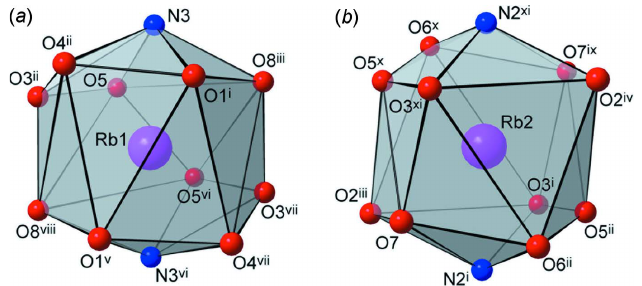
Figure 2 Twelvefold coordination environments adopted by the Rb1 and Rb2 ions in ( 1 ), in the form of distorted icosahedra. The coordination of the two Cs ions in ( 2 ) is almost identical. [Symmetry codes: (i) x , y + 1, z ; (ii) (cid:3) x + 1 y + 1 , (cid:3) z + 1 ; (iii) (cid:3) x + 1 2 2 (cid:3) z + 1 ; (vi) (cid:3) x + 1, y , (cid:3) z + 1 2 (cid:3) x , (cid:3) y + 1, (cid:3) z ; ( x ) x (cid:3) 1